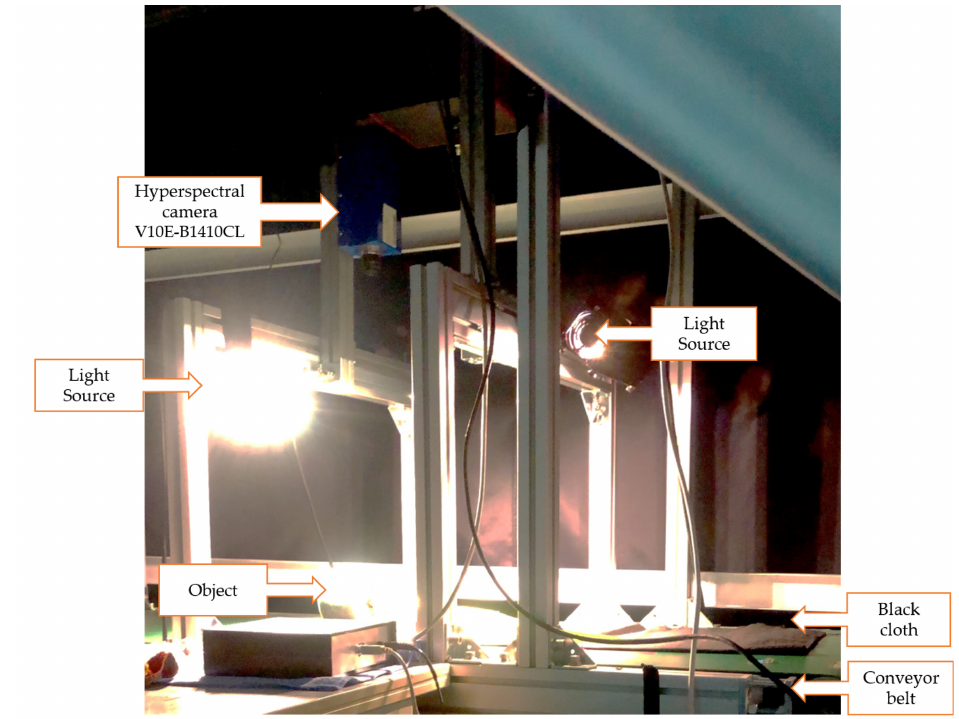
Figure 3. Hyperspectral imaging